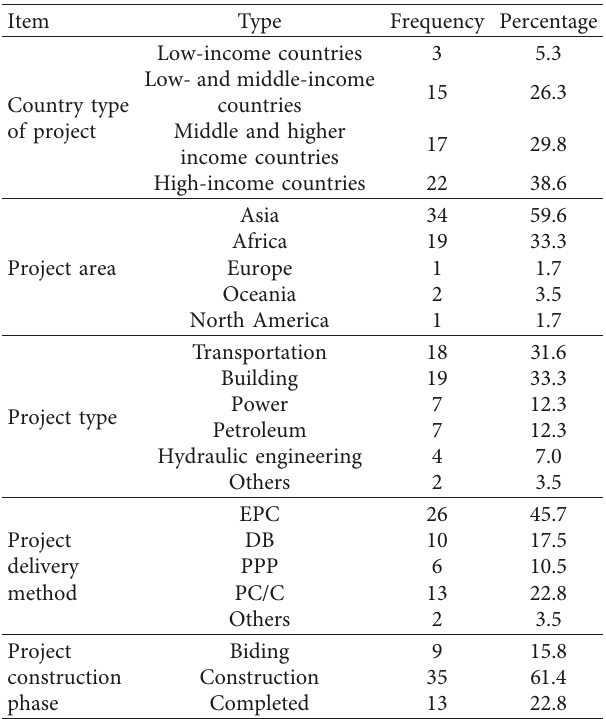
Figure 1: Theoretical model of the study. Table 1: Descriptive statistical analysis of the sample distribution projects ( N �